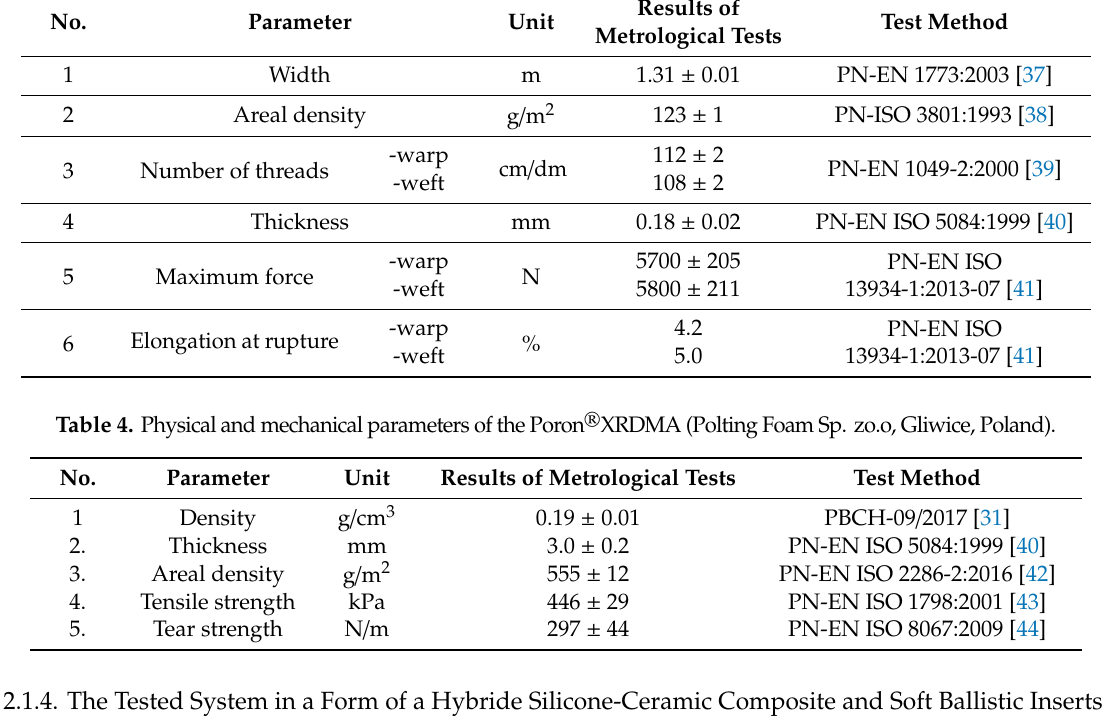
Table 3. Physical and mechanical parameters of the aramid fabric Twaron  CT 612 (Teijin, Wuppertal, Table 3. PhysicalandmechanicalparametersofthearamidfabricTwaron ® CT612(Teijin,Wuppertal,Germany). Germany).